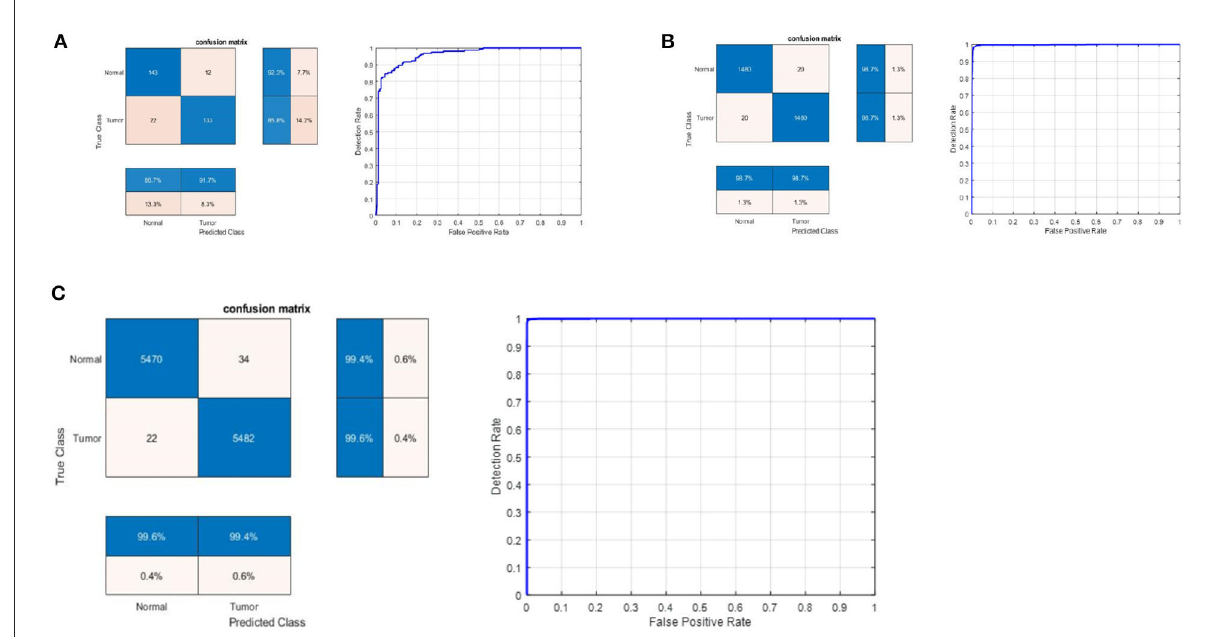
FIGURE6 Confusion matrix and ROC curve for BRAIN-TUMOR-net on (A) First dataset, (B) Second dataset, and (C) Third dataset.